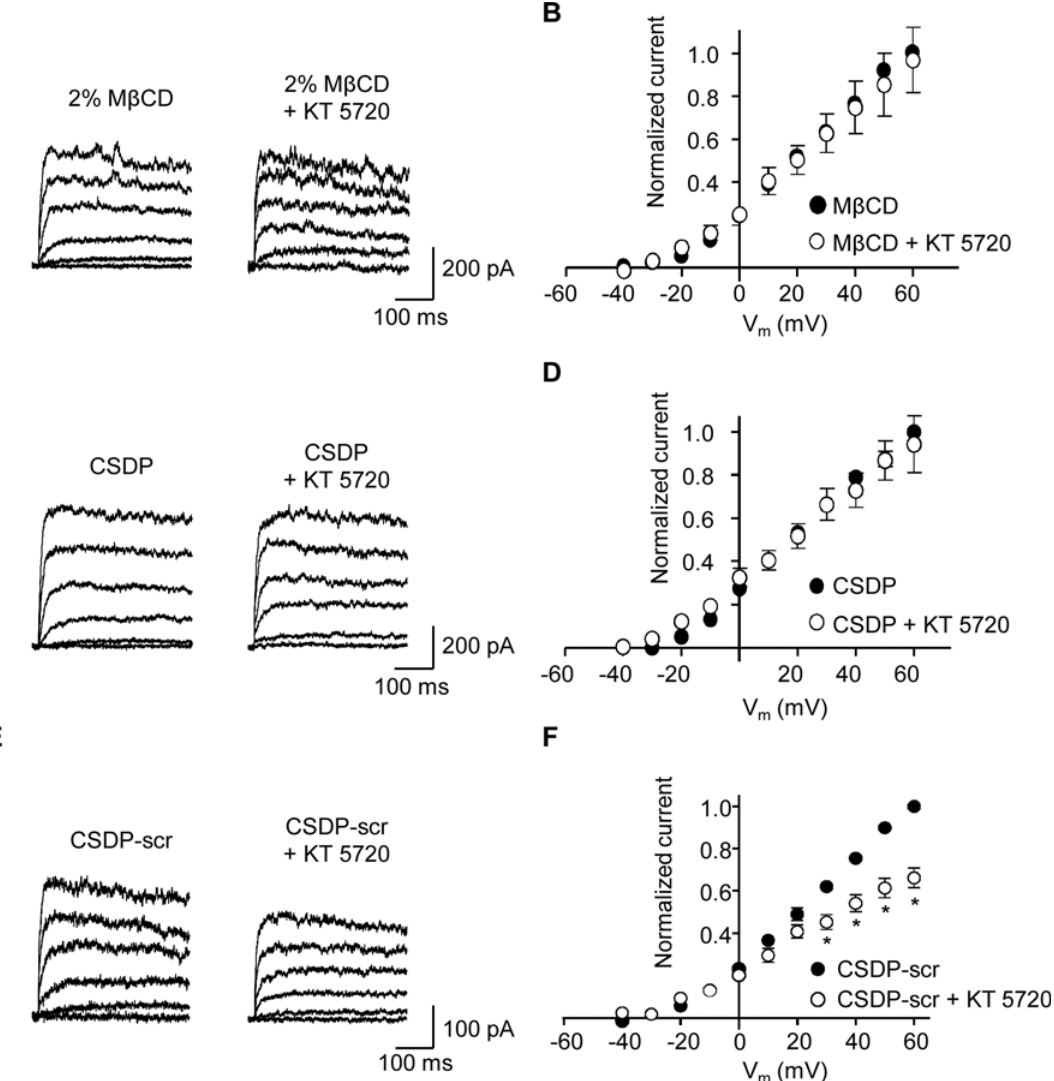
Fig 7. Inhibition of K v current by KT 5720 is abolished by disruption of caveolae. ( A ) Representative K v currents following 60 min pre-treatment with 2% methyl- β -cyclodextrin (M β CD) before and after application of 1 μ M KT 5720. ( B ) Mean I-V plots (normalized to control current in the presence of M β CD at +60 mV), before and after application of 1 μ M KT 5720 (n = 5). ( C ) Representative K v currents in the presence of the caveolin scaffolding-domain peptide (CSDP, 100 μ M) in the patch pipette, before and after application of KT 5720 (1 μ M). ( D ) Mean I-V plots (normalized to the current at +60 mV in the presence